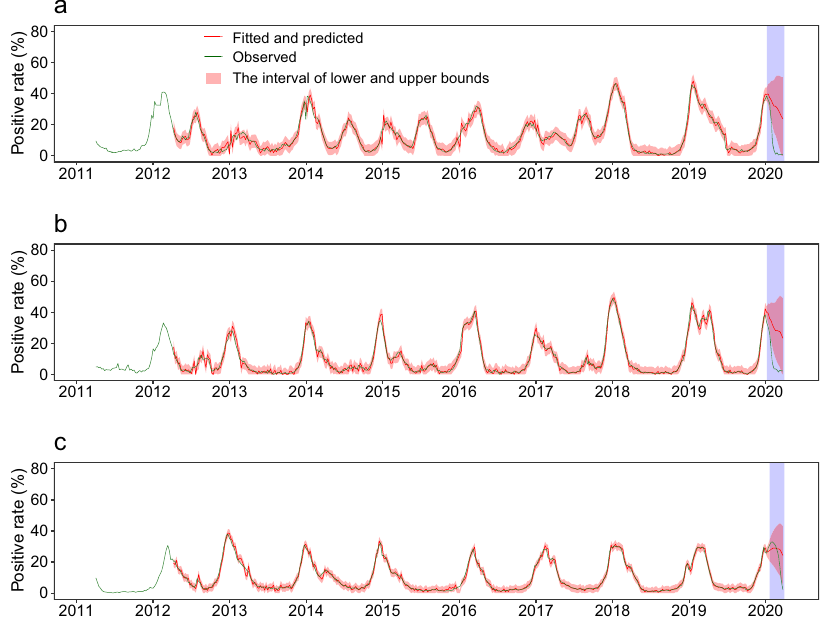
Fig. 4 Observed, fi tted, and predicted in fl uenza test positivity rate from 2011 to 2020. a Southern China. b Northern China. c The US. The blue shaded parts indicate the estimates under normal seasonal in fl uenza activities and shows 95% con fi dence intervals of estimates.